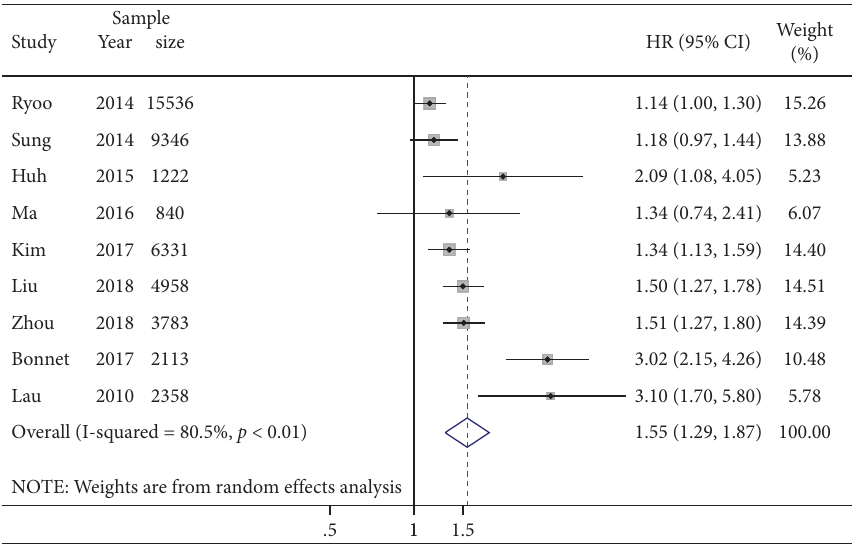
Figure 3: NAFLD versus non-NAFLD on the risk of incident HTN. Forest plot and pooled estimates of 9 eligible studies with data on 46,487